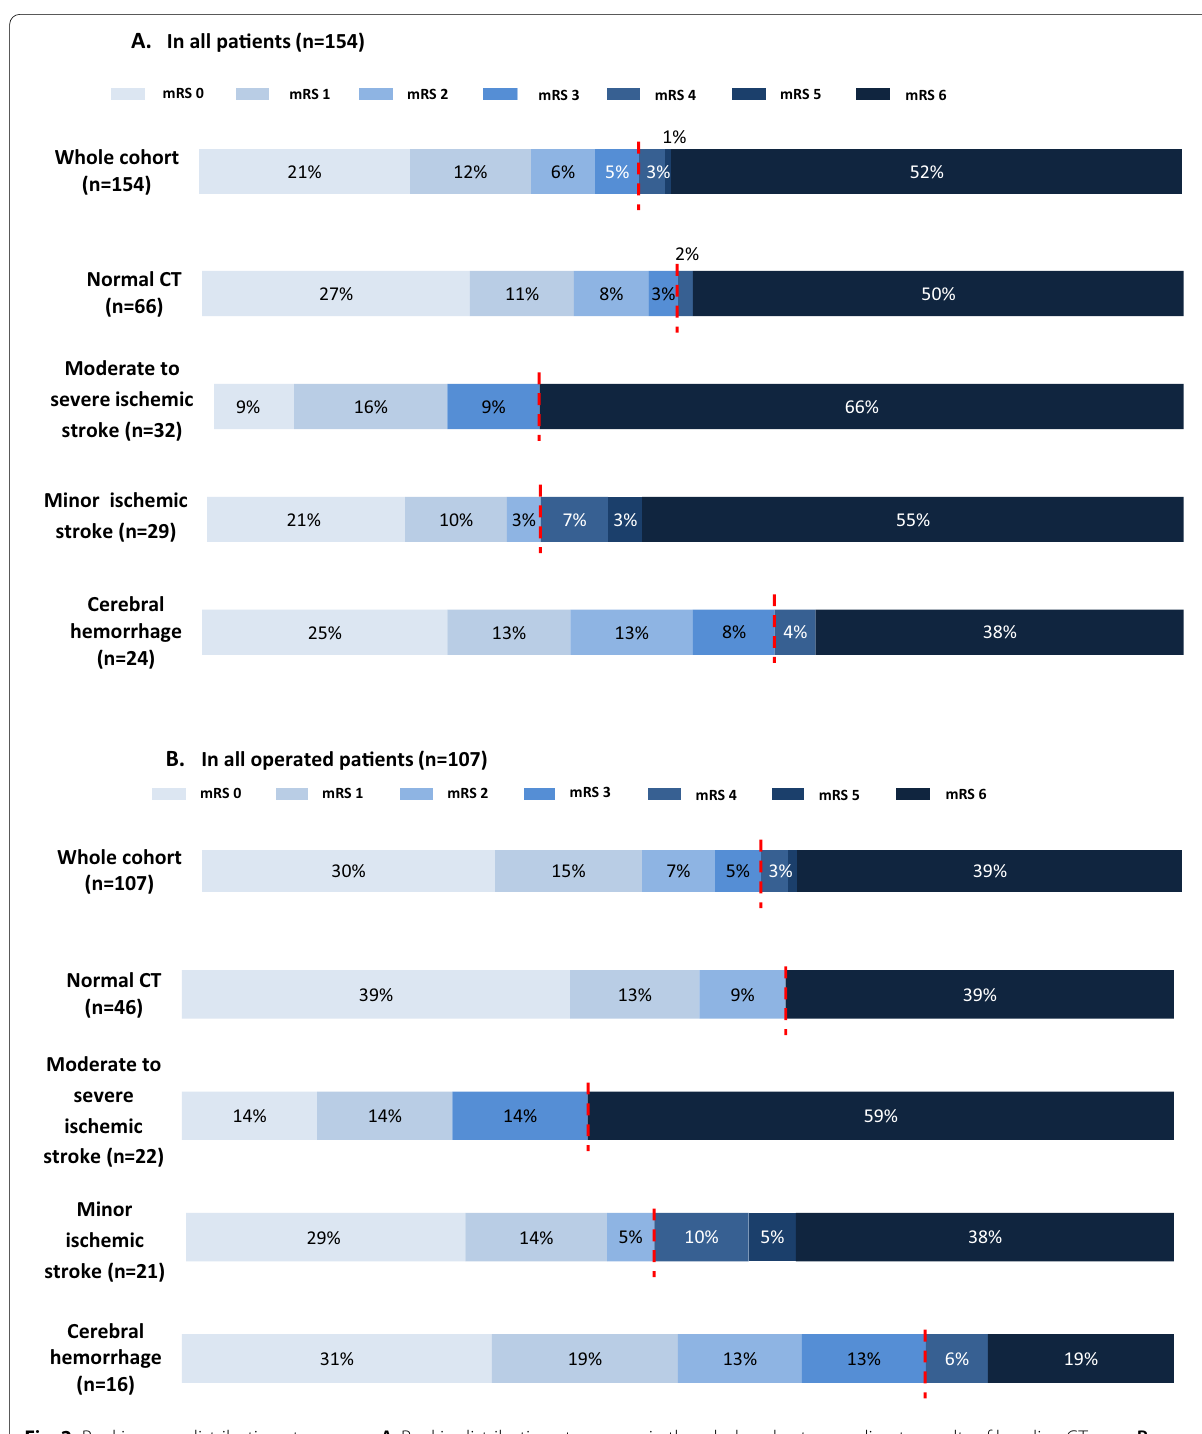
Fig. 2 Rankin score distribution at one year: A . Rankin distribution at one year in the whole cohort, according to results of baseline CT‑scan; B . Rankin distribution at one year in operated patients according to results of baseline pre‑operative CT‑scan. In both A and B, the red line indicates the limit between patients with favorable (mRS 0–3) or unfavorable (mRS 4–6) outcome. CT computed